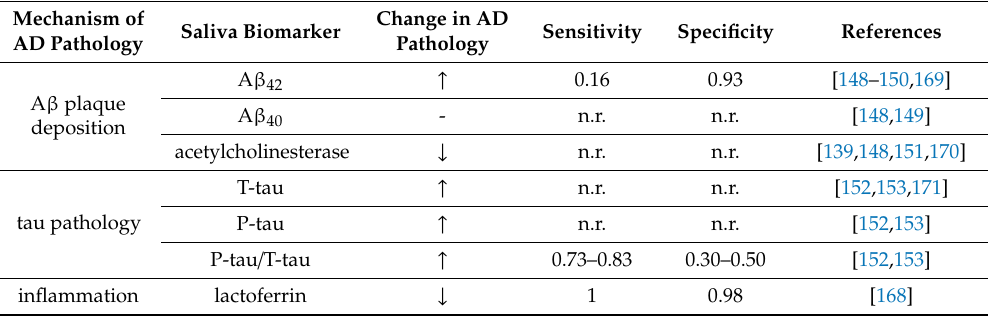
Table 3. The major changes of the identified saliva biomarkers for AD and the associated mechanisms of